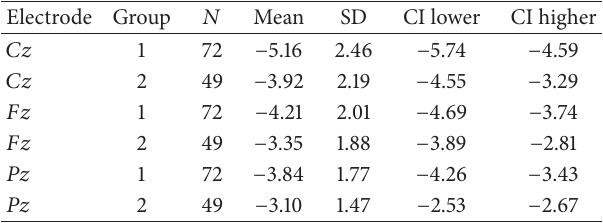
Table 1: Descriptive statistics for groups by electrode location.